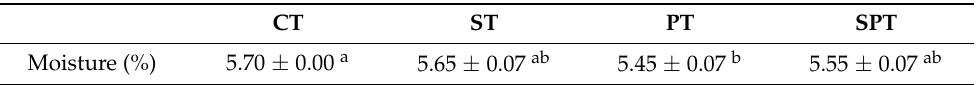
Table 1. Moisture (%) values * in fermented and dried cocoa beans, inoculated with different yeasts inocula: CT—control fermentation, ST— Saccharomyces cerevisiae inoculum, PT— Pichia